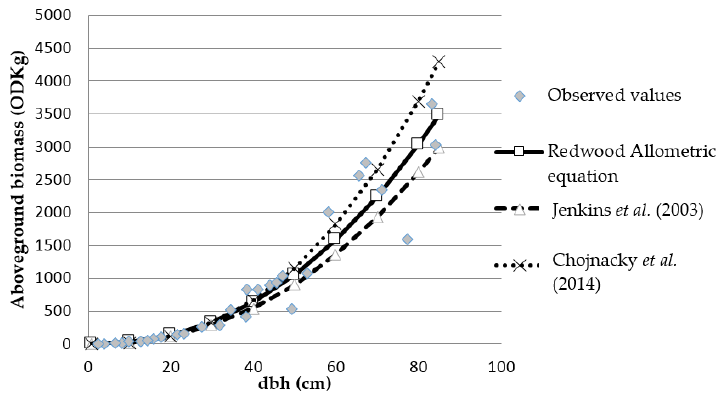
Figure 3. Graph of localized allometric models compared with Jenkins et al. [12] and Chojnacky et al. [6] for predicting total aboveground biomass of coast redwood in Oven Dry Kilogram (ODKg) against dbh (diameter at breast height).